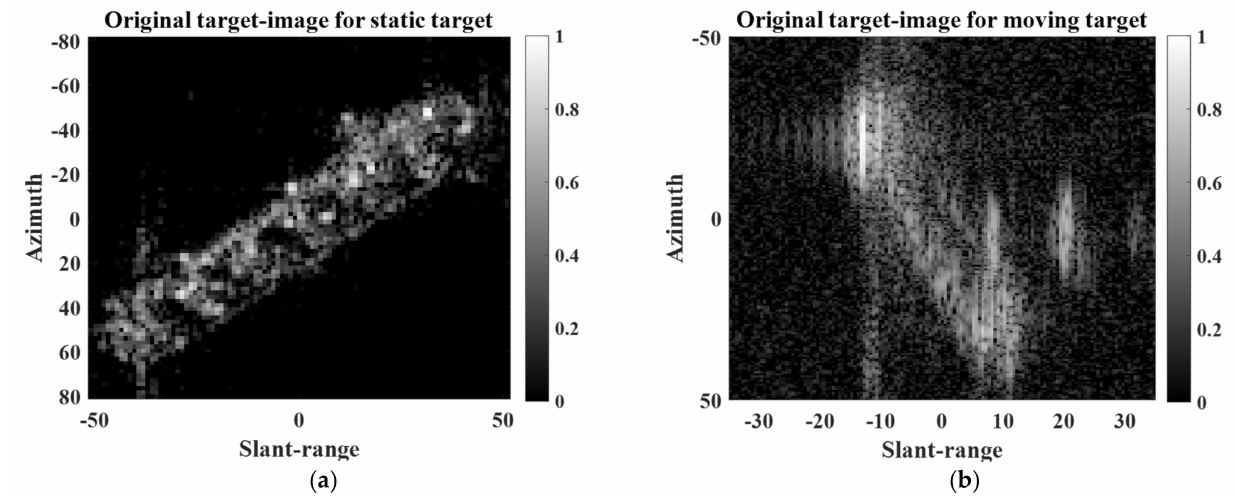
Figure 2. Examples of small target images: ( a ) static target, ( b ) moving